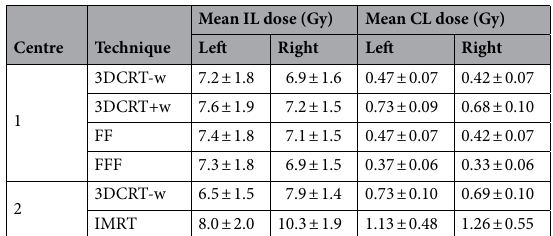
Table 1. Mean doses to the ipsilateral and contralateral lung (IL, CL) for patients with left- or right-sided breast cancer. Listed are the average values and standard deviations over the respective patient groups.